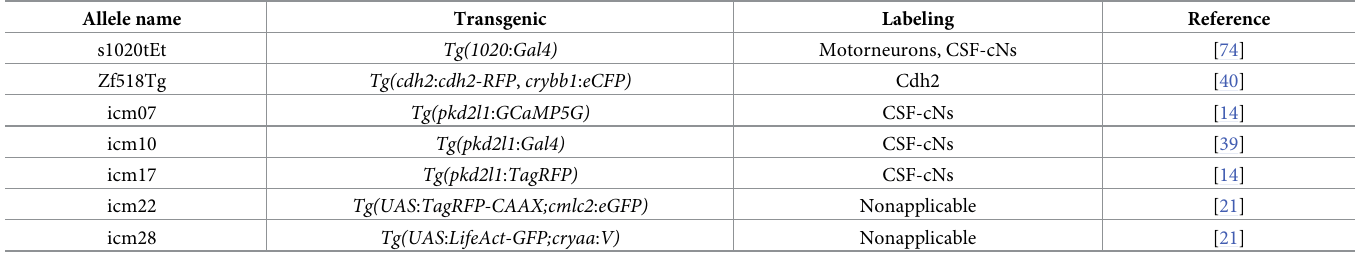
Table 1. Transgenic lines used in our study.